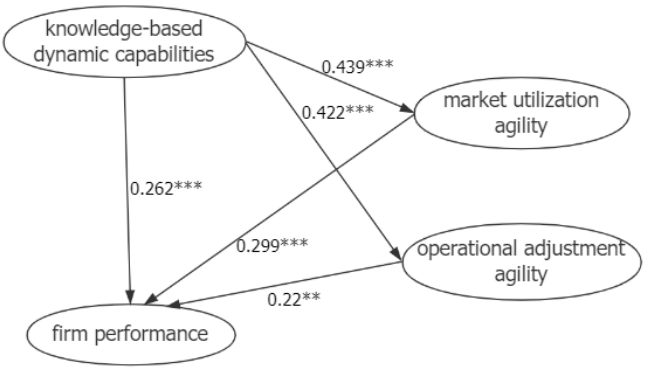
Figure 2. Model path parameters. *** and ** indicate p < 0.001 and p < 0.01, respectively.